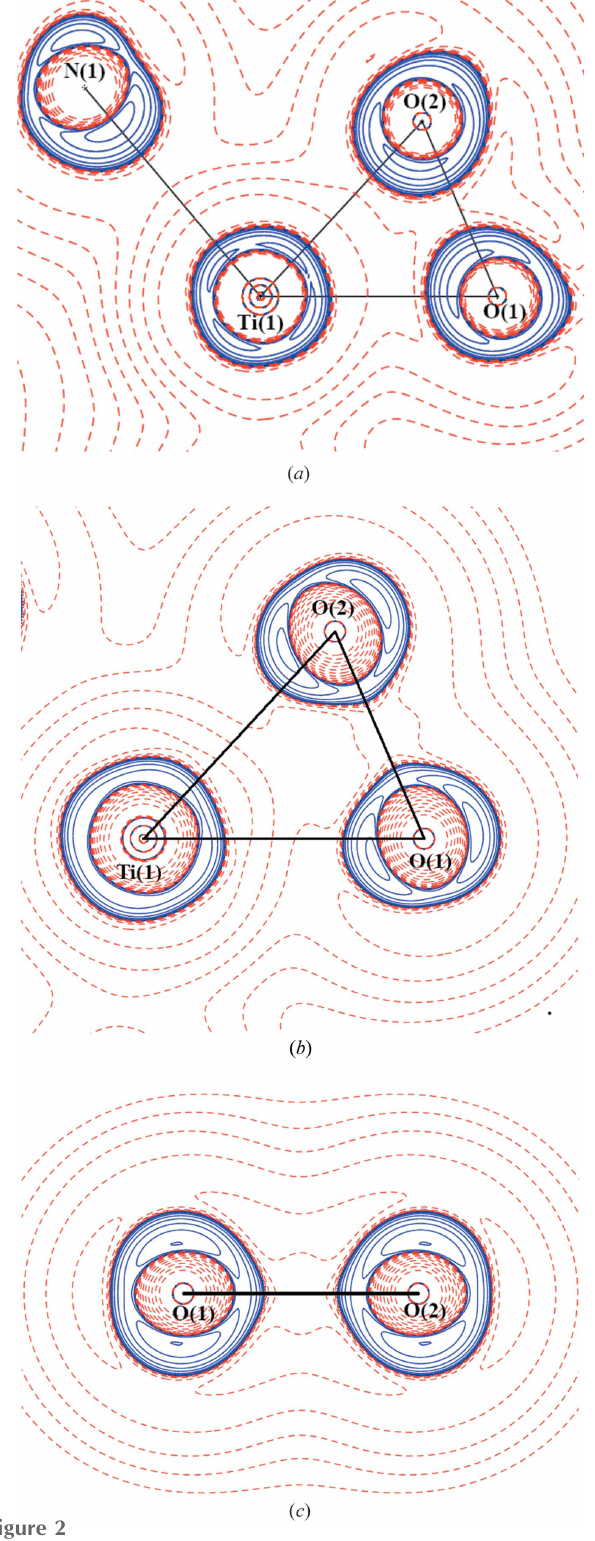
Figure 2 ( a ) Experimental Laplacian distribution L ( r ) ’ r 2 (cid:8) ( r ) in the Ti(1)— O(1)—O(2) plane; ( b ) theoretical Laplacian distribution L ( r ) ’ r 2 (cid:8) ( r ) in the Ti(1)—O(1)—O(2) plane; ( c ) theoretical Laplacian of the free O 22 (cid:3) anion. Contours are drawn at (cid:3) 1.0 (cid:6) 10 (cid:3) 3 , (cid:8) 2.0 (cid:6) 10 n , (cid:8) 4.0 (cid:6) 10 n , (cid:8) 8.0 (cid:6) 10 n ( n = (cid:3) 3, (cid:3) 2 (cid:3) 1, 0, +1, +2 +3) e A˚ (cid:3) 5 , with positive contours drawn with a solid blue line and negative contours with a dashed red